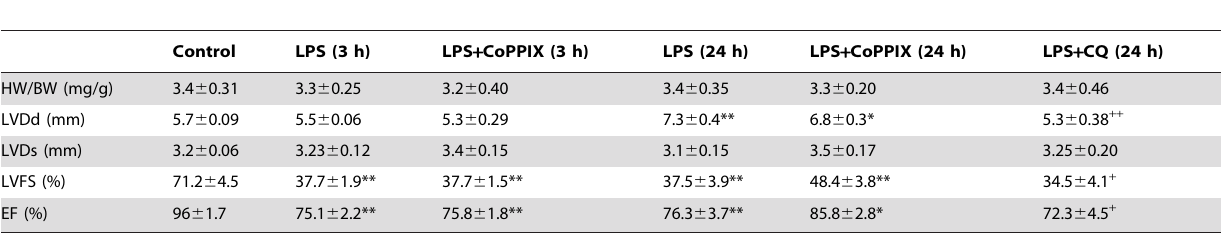
Table 1. Echocardiographic parameters of left ventricular function were measured with LPS treatment (15 mg/kg) with or without CoPPIX (5 mg/kg) and CQ (20 mg/kg) for 3 and 24 h.